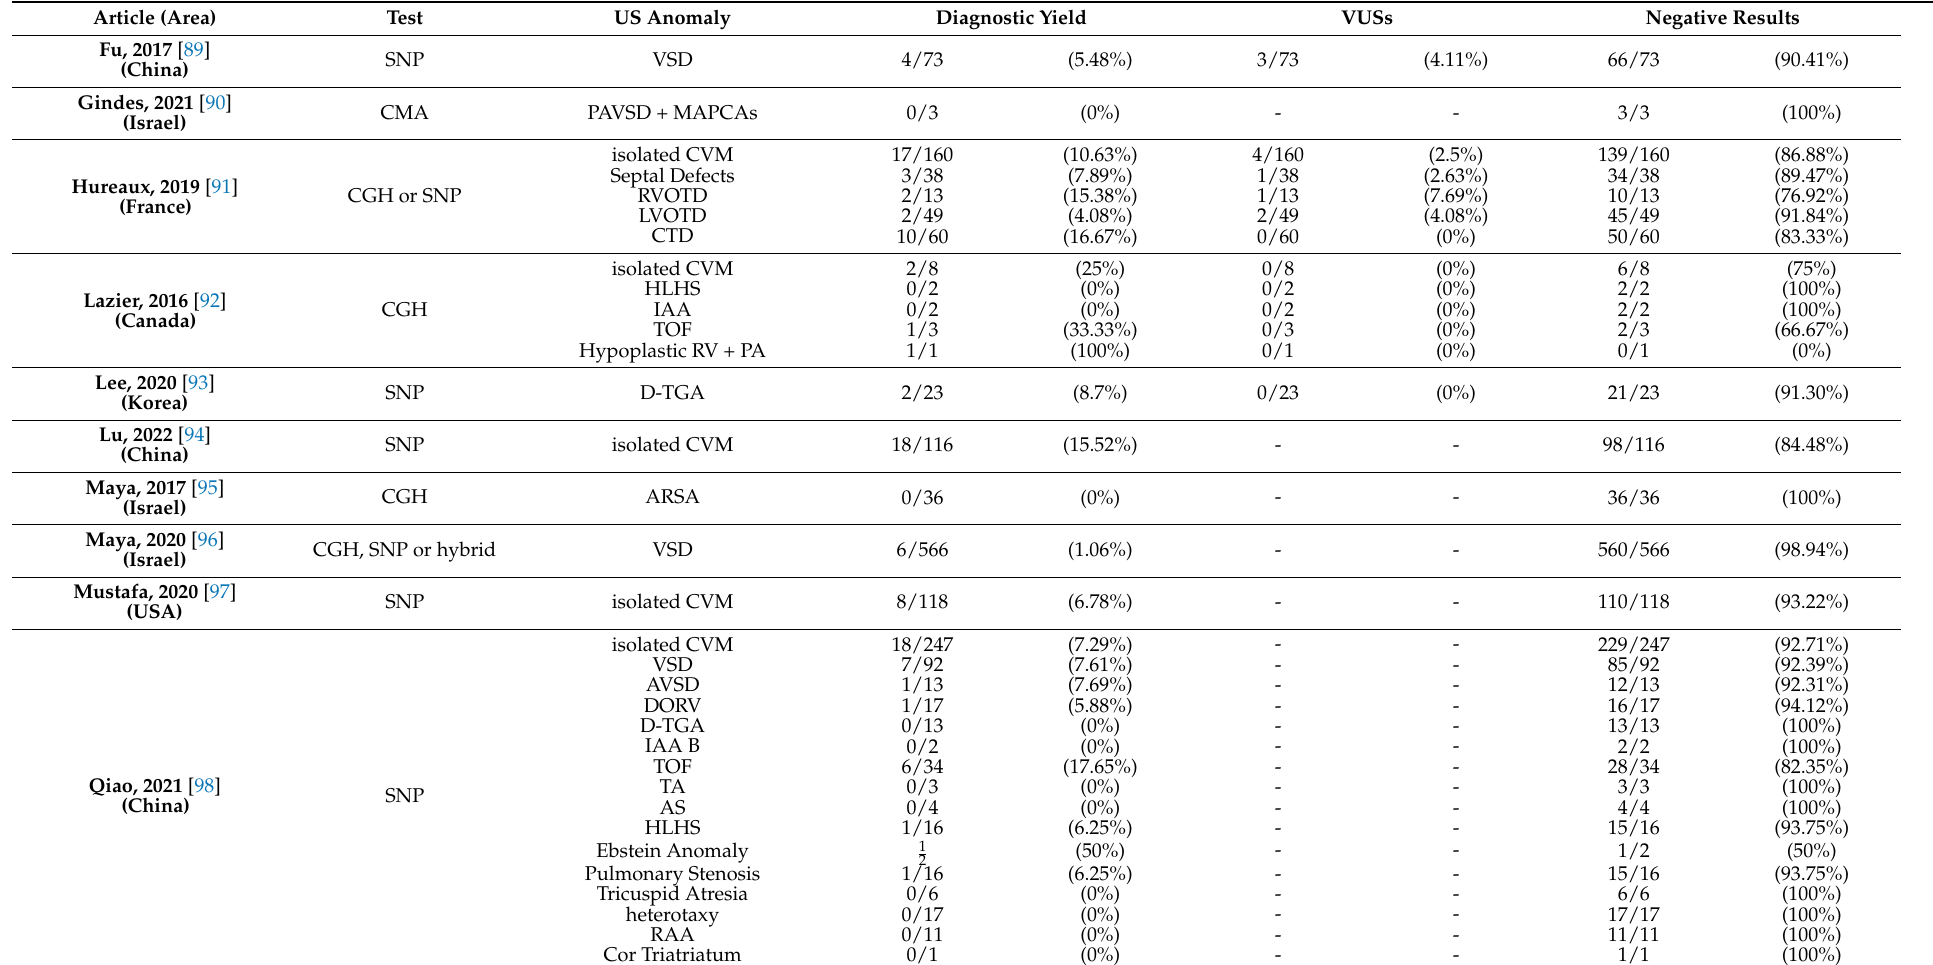
Table 1. Systematic review of incremental diagnostic yield and VUS rate detected by CMA for each subgroup of